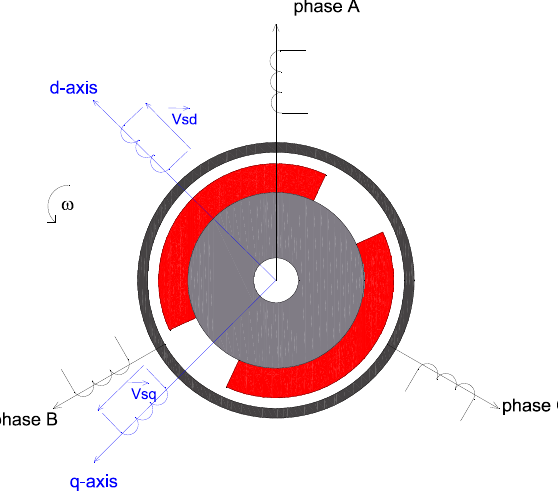
Figure 2. Schematic representation of a two poles three-phase brushless Permanent Magnet (PM) machine.